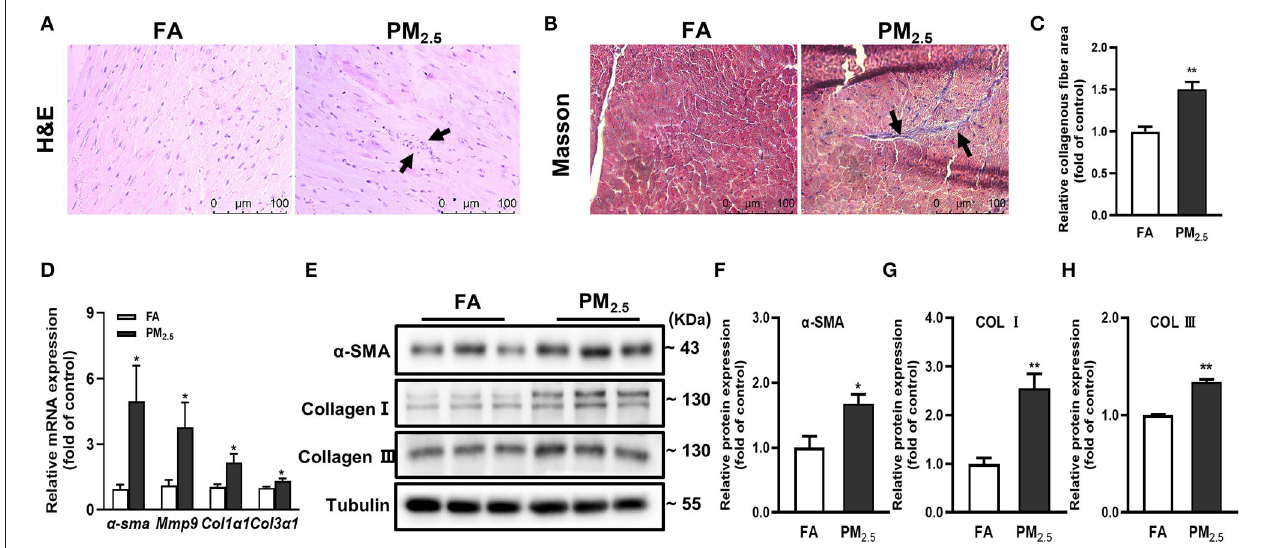
FIGURE 1 | PM 2.5 induced cardiac inflammation and fibrosis. (A) Representative images of hematoxylin-eosin (H&E) staining in heart issue, scale bars: 100 µ m. The black arrow indicated the infiltration of inflammatory cells. (B) Representative images of Masson staining in heart issue, scale bars: 100 µ m. (C) Quantitation of cardiac fibrosis area. (D) Relative mRNA expressions of α -SMA, mmp9, Col1 α 1, and Col3 α 1 in the hearts of mice were analyzed by qPCR. (E–H) Relative protein expressions of α -SMA, Col I and Col III in the hearts of mice were analyzed by Western blot. All the data were presented as mean ± SEM ( t -test), n = 5, *indicates p < 0.05, **indicates p <